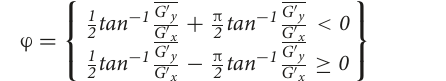
FIGURE7 Flame color distribution.